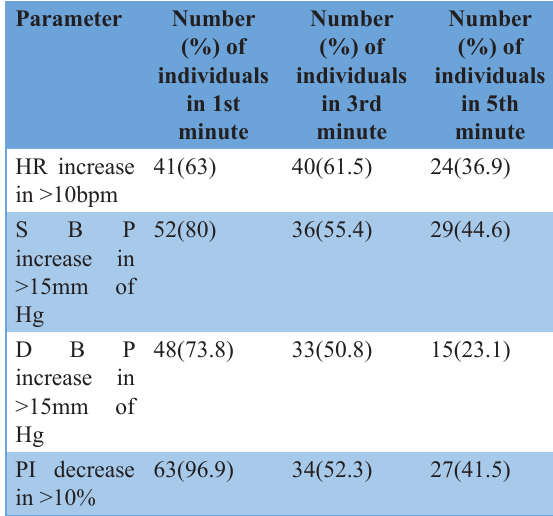
Table 4. Comparison of haemodynamic stress